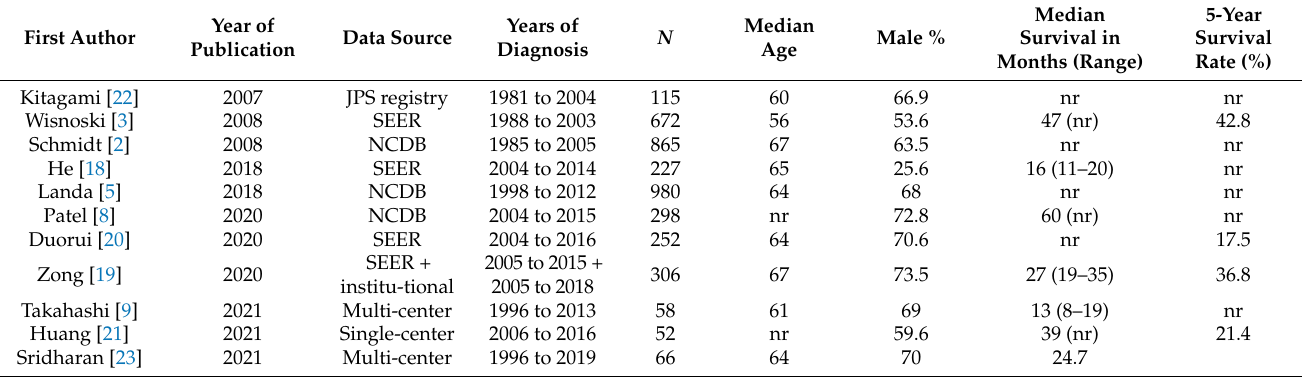
Table 4. Summary of studies on PACC with more than 50 patients